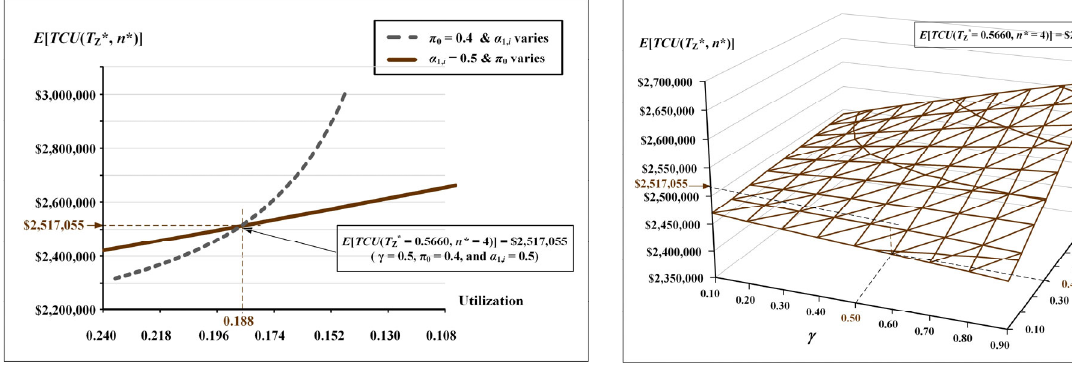
Fig. 15. E [ TCU ( T Z *, n *)]’s behavior vis-à-vis the collective impacts of γ and π 0